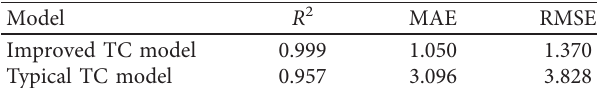
Table 4: The determination coefficient ( R 2 ), mean absolute error (MAE), and root-mean-square error (RMSE) values of the im- proved Timur–Coates (TC) model and typical TC